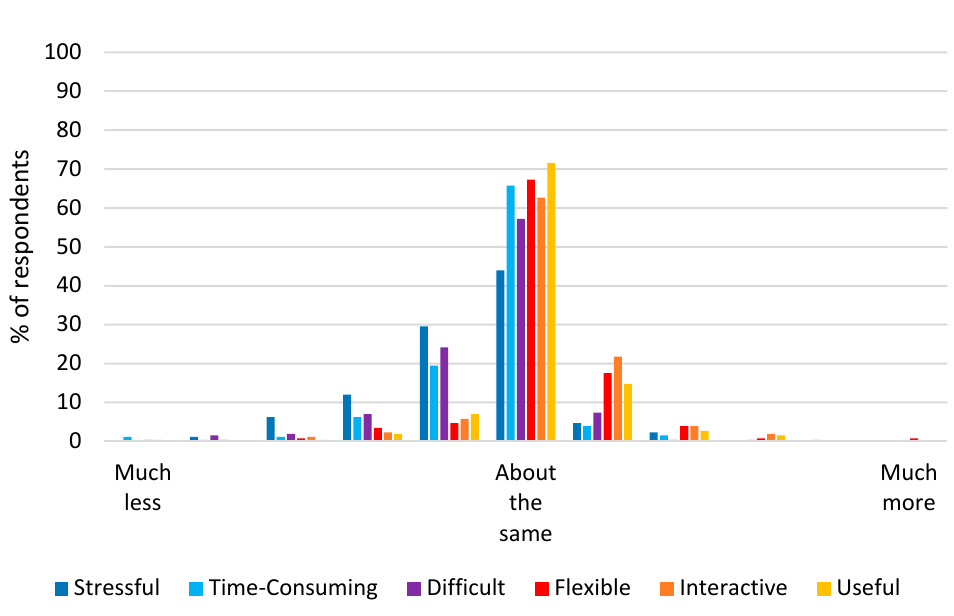
Figure 3. Differences between individual respondents’ initial experiences of online teaching versus their experiences by the end of semester ( n = 245–250).